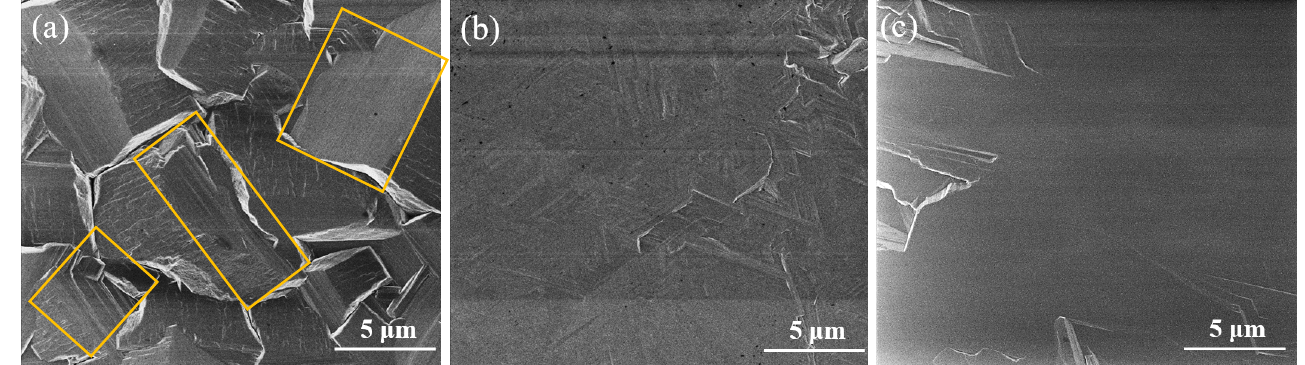
Figure 10. The surface SEM image of β -Ga 2 O 3 thick film grown directly on sapphire substrate ( a ). The surface SEM image of β -Ga 2 O 3 thick film grown on β -(Al x Ga 1 − x ) 2 O 3 /sapphire substrate by carbothermal reduction ( b ) and HVPE ( c ) methods.